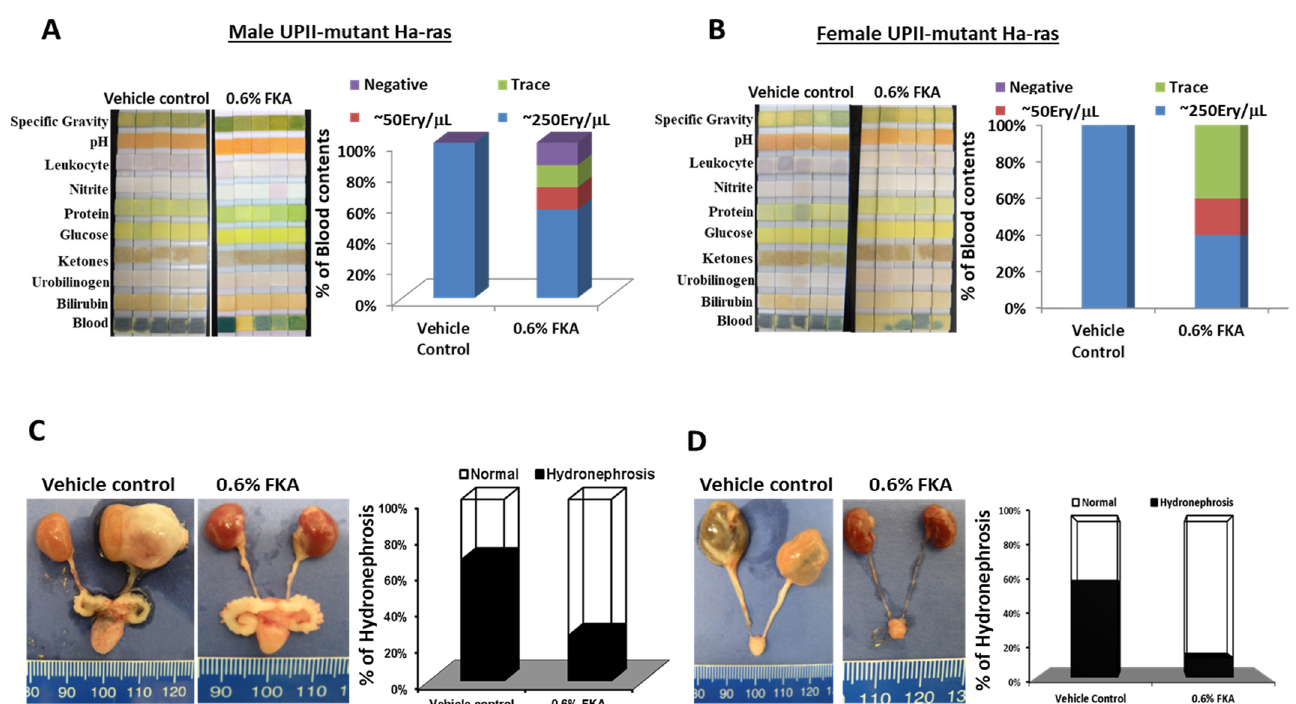
Figure 4. The chemopreventive effect of dietary FKA on hematuria and hydronephrosis. ( A , B ) Photographs of dipsticks after loading with urine from male and female homozygous UPII-mutant Ha-ras transgenic mice which were fed with control diet or diet containing 0.6% FKA for 4 months ( left panel ), and percentage of mice with hematuria in control and FKA diet groups ( right panel ). ( C , D ) Macroscopic examination showing enlarged kidneys in control-diet-fed mice compared to 0.6% FKA-diet-fed mice ( left panel ), and percentage of mice with hydronephrosis in control and FKA diet groups ( right panel ).